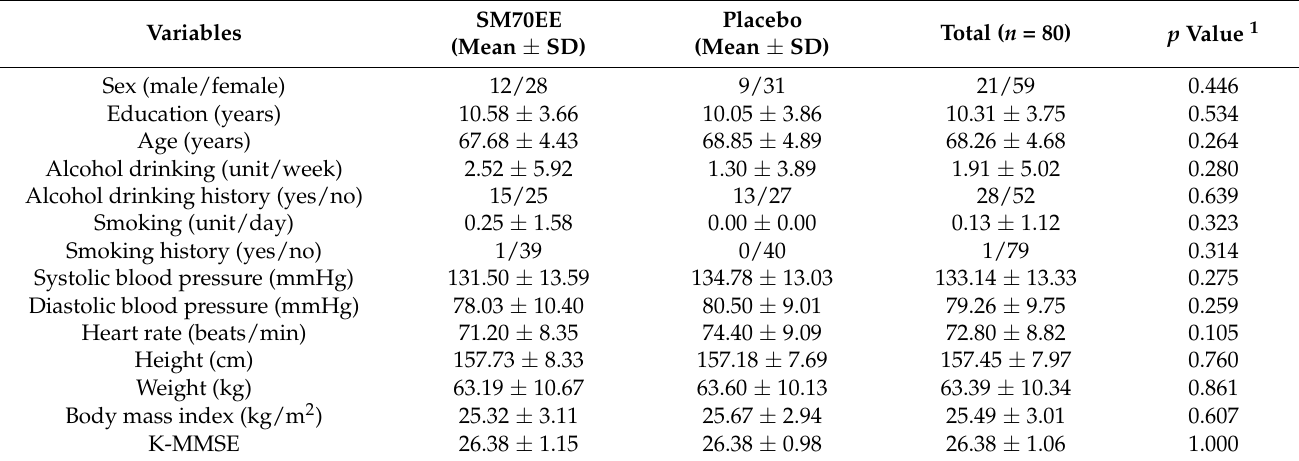
Table 1. Demographics of study participants who were placed through random selection into placebo or SM70EE